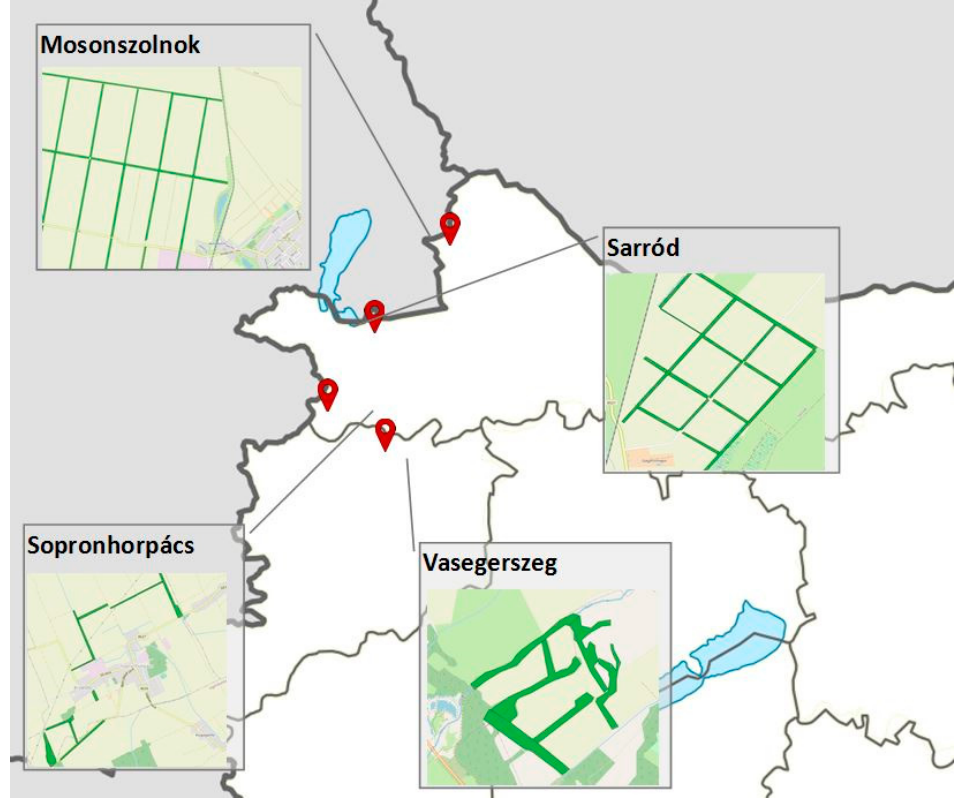
Figure 1. Position and optic of the four study areas in NW Hungary. The two southern study areas belong to the West-Hungarian Borderland, while the two northern ones to the Lesser Plain. An important common feature of the sample areas is the significant climatic drought caused by the frequent descending airflow (foehn)